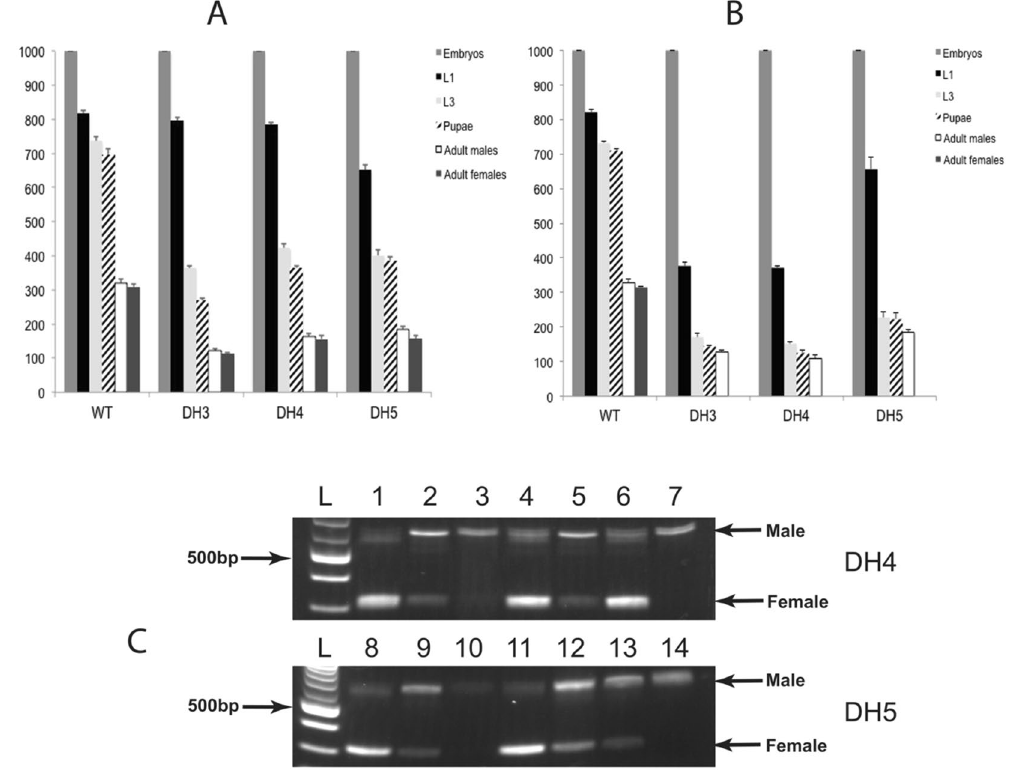
Figure 6. Staged lethality of double-homozygous transgenic sexing strains. DH3, DH4, DH5 and WT flies reared on diet with a high concentration of tetracycline ( A ) and without (WT, DH5) or limited tetracycline ( +− W, DH3, DH4) ( B ). 1000 embryos were collected and the number of L1, L3, pupae, adult males and adult females were recorded. Error bars show the standard error of the mean (n = 3). The relative proportion of male and female larvae at different stages was determined by RT-PCR ( C ). With the Lctra primer pair used, 636 bp and 325 bp products were obtained from male and female transcripts respectively. RNA was isolated from WT, DH4 and DH5 strains. cDNA prepared from RNA from adult WT male and female RNA was mixed at ratios of 1:1 (lanes 1,8), 10:1 (lanes 2,9) and 100:1 (lanes 3,10) prior to amplification. Samples from DH4 were: 4) 100 L1 under ++ W condition; 5) 100 L1 under +− W condition; 6) 100 L2 under ++ W/ + M condition; 7) 100 L2 under +− W/ − M condition. Samples from DH5 were: 11) 100 L3 under ++ W/ + M condition; 12) 100 L1 under − W condition; 13) 100 L2 under − W/ − M condition; 14) 100 L3 under − W/ − M condition. L, DNA